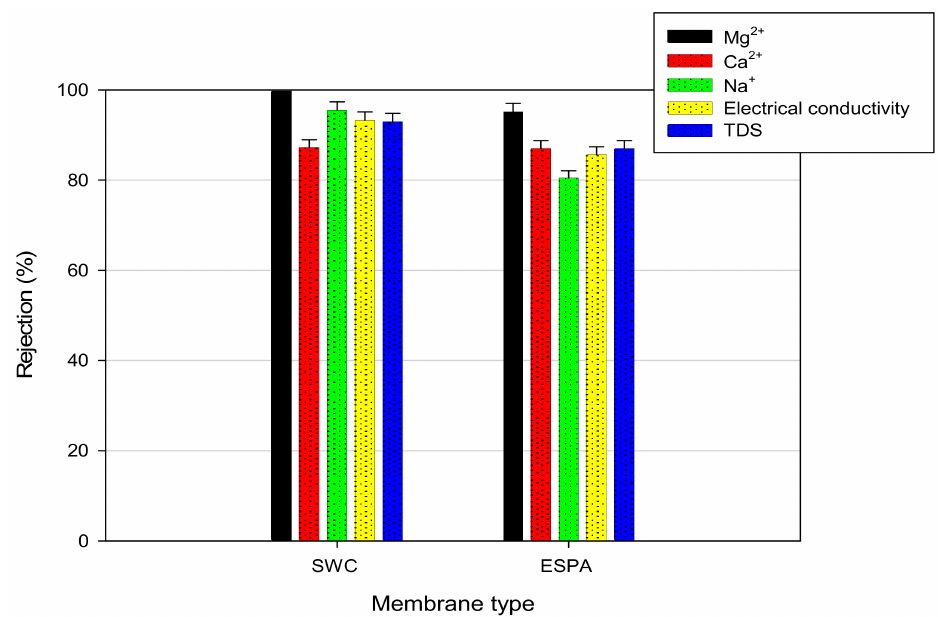
Figure 3. Rejection of RO membranes towards ions, electrical conductivity (EC) and total dissolved solids (TDS).